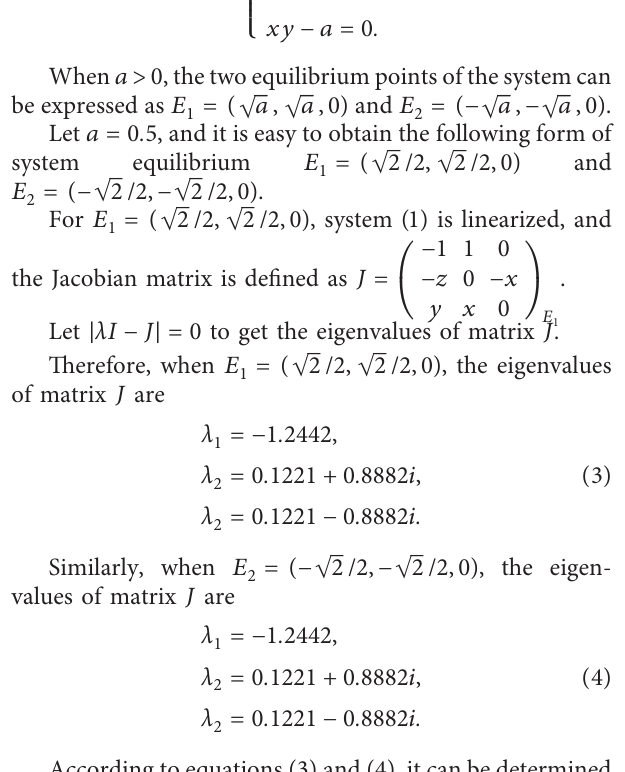
Figure 3: x - z phase plane of the chaotic